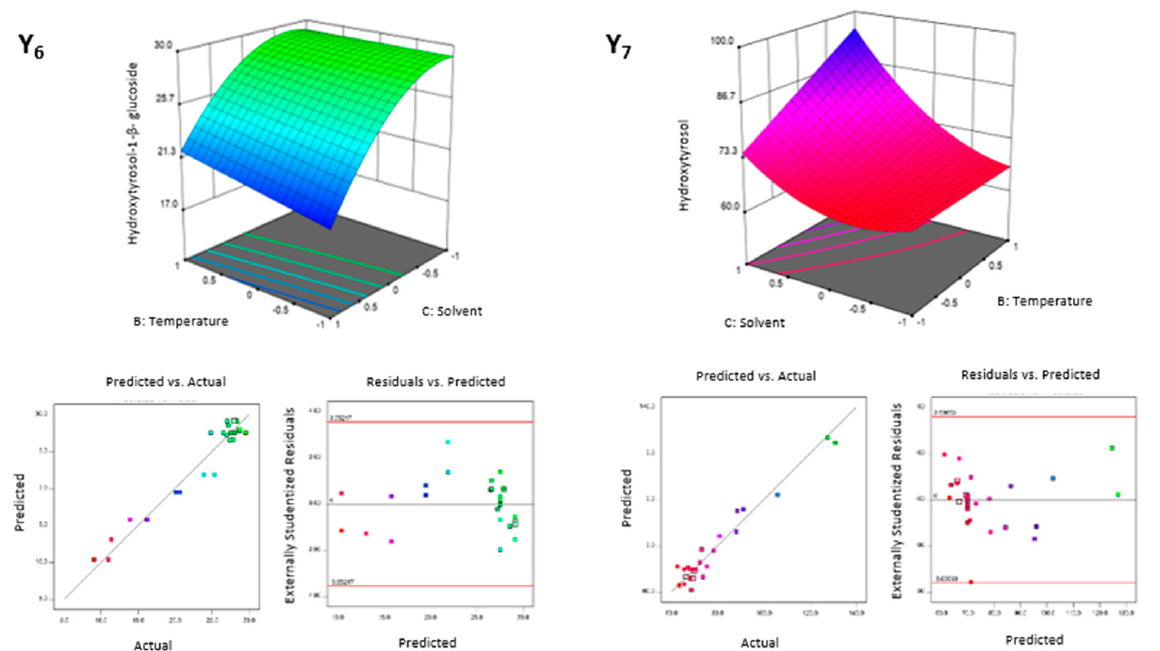
Figure 3. RSM graphs from the responses Y 6 (Hydroxytyrosol-1-beta-glucoside, mg/g Ext) and Y 7 (Hydroxytyrosol, mg/g Ext), with statistical diagnostic representations. Each graph displays temperature vs solvent factors, with a time factor adjusted to 0, along with two statistical diagnostics attached. On the left, the graphical representation of the adjustment between predicted vs actual points, and on the right, the graphical representation of residuals vs predicted points.